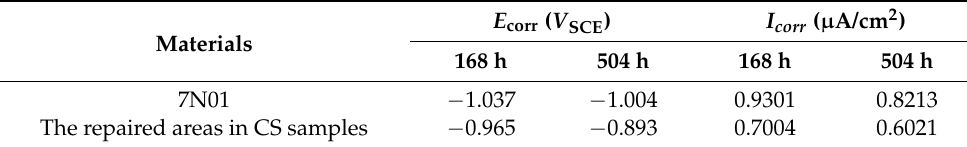
Figure 11. The potentiodynamic polarization curves of the samples after the alternate immer- sion tests. Table 4. Related electrochemical parameters of the